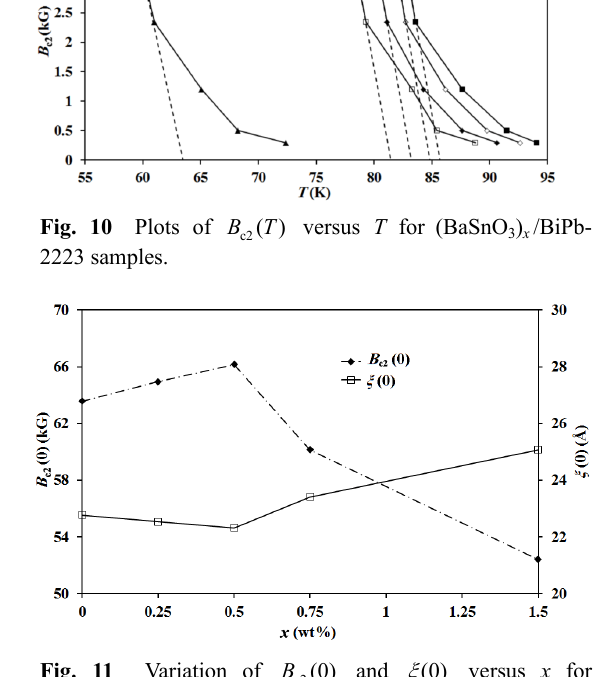
(0) B and (0)  versus x for Fig. 11 Variation of c2 (BaSnO 3 ) x /BiPb-2223